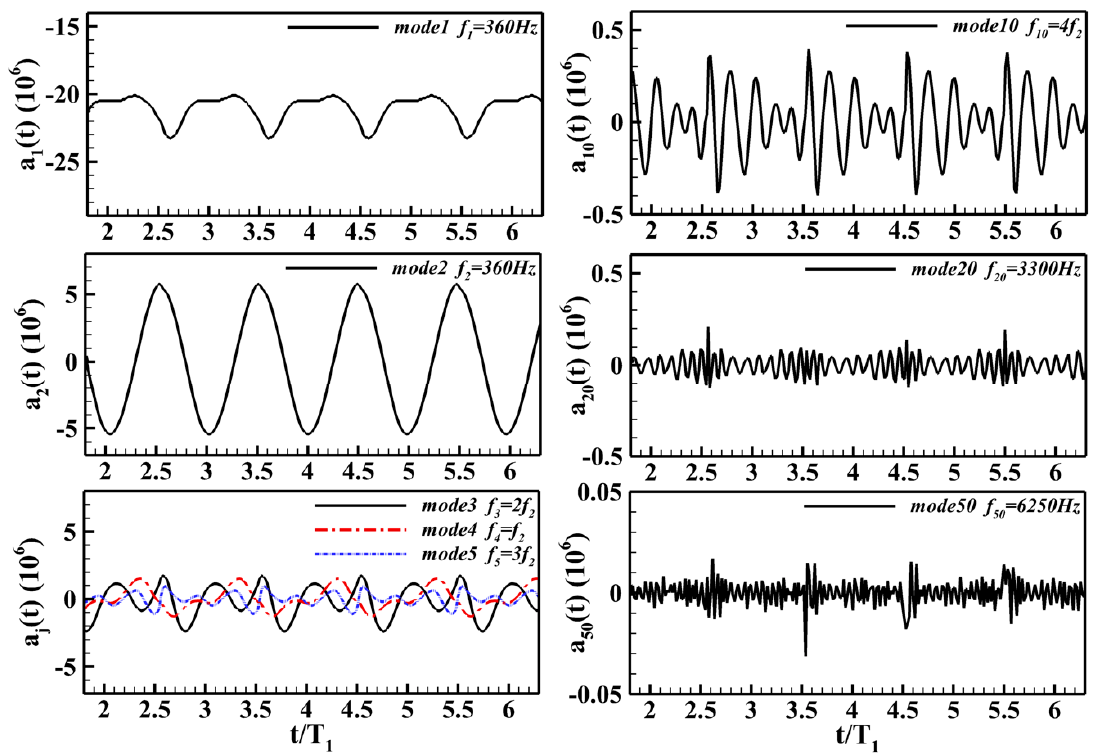
a t . Figure 10. Time history of several modal coe ffi cients a j ( t ) j